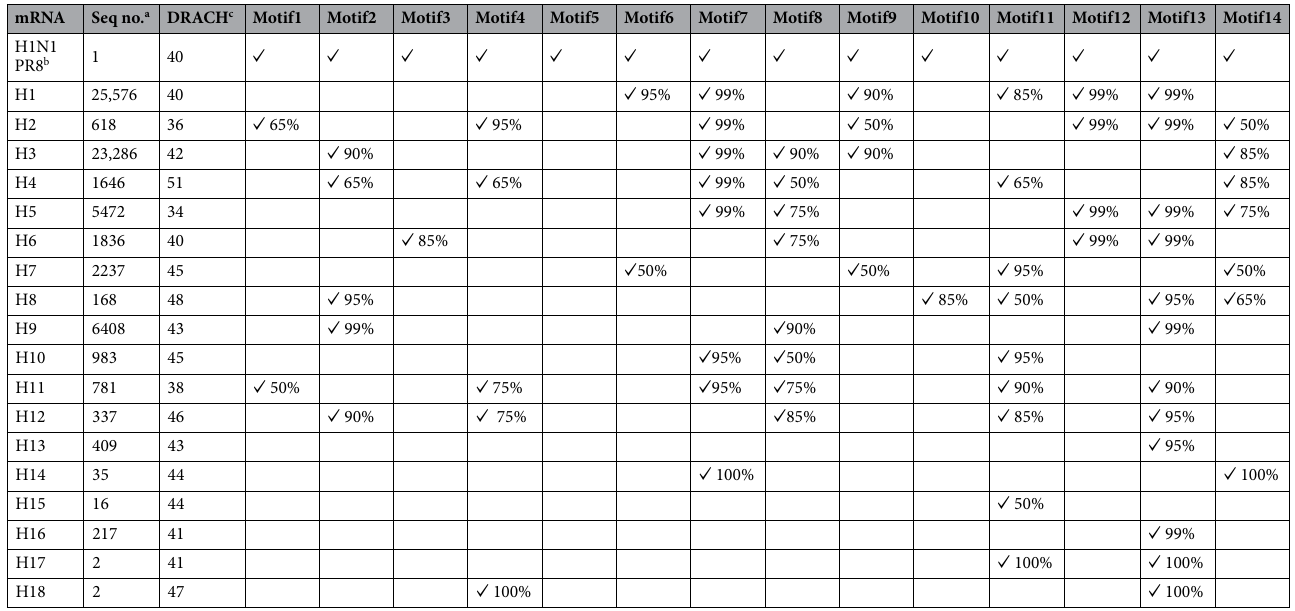
Table 1. Summary of conserved DRACHs distributions among all IAVs HA mRNAs. a The number of HA sequences listed on IRD and analyzed here in this study. b The reference influenza A virus strain utilized in this study, A/Puerto Rico/8/34/Mount Sinai, HA accession no. AF389118. c The total number of the possible DRACH motifs located in the consensus sequence in each